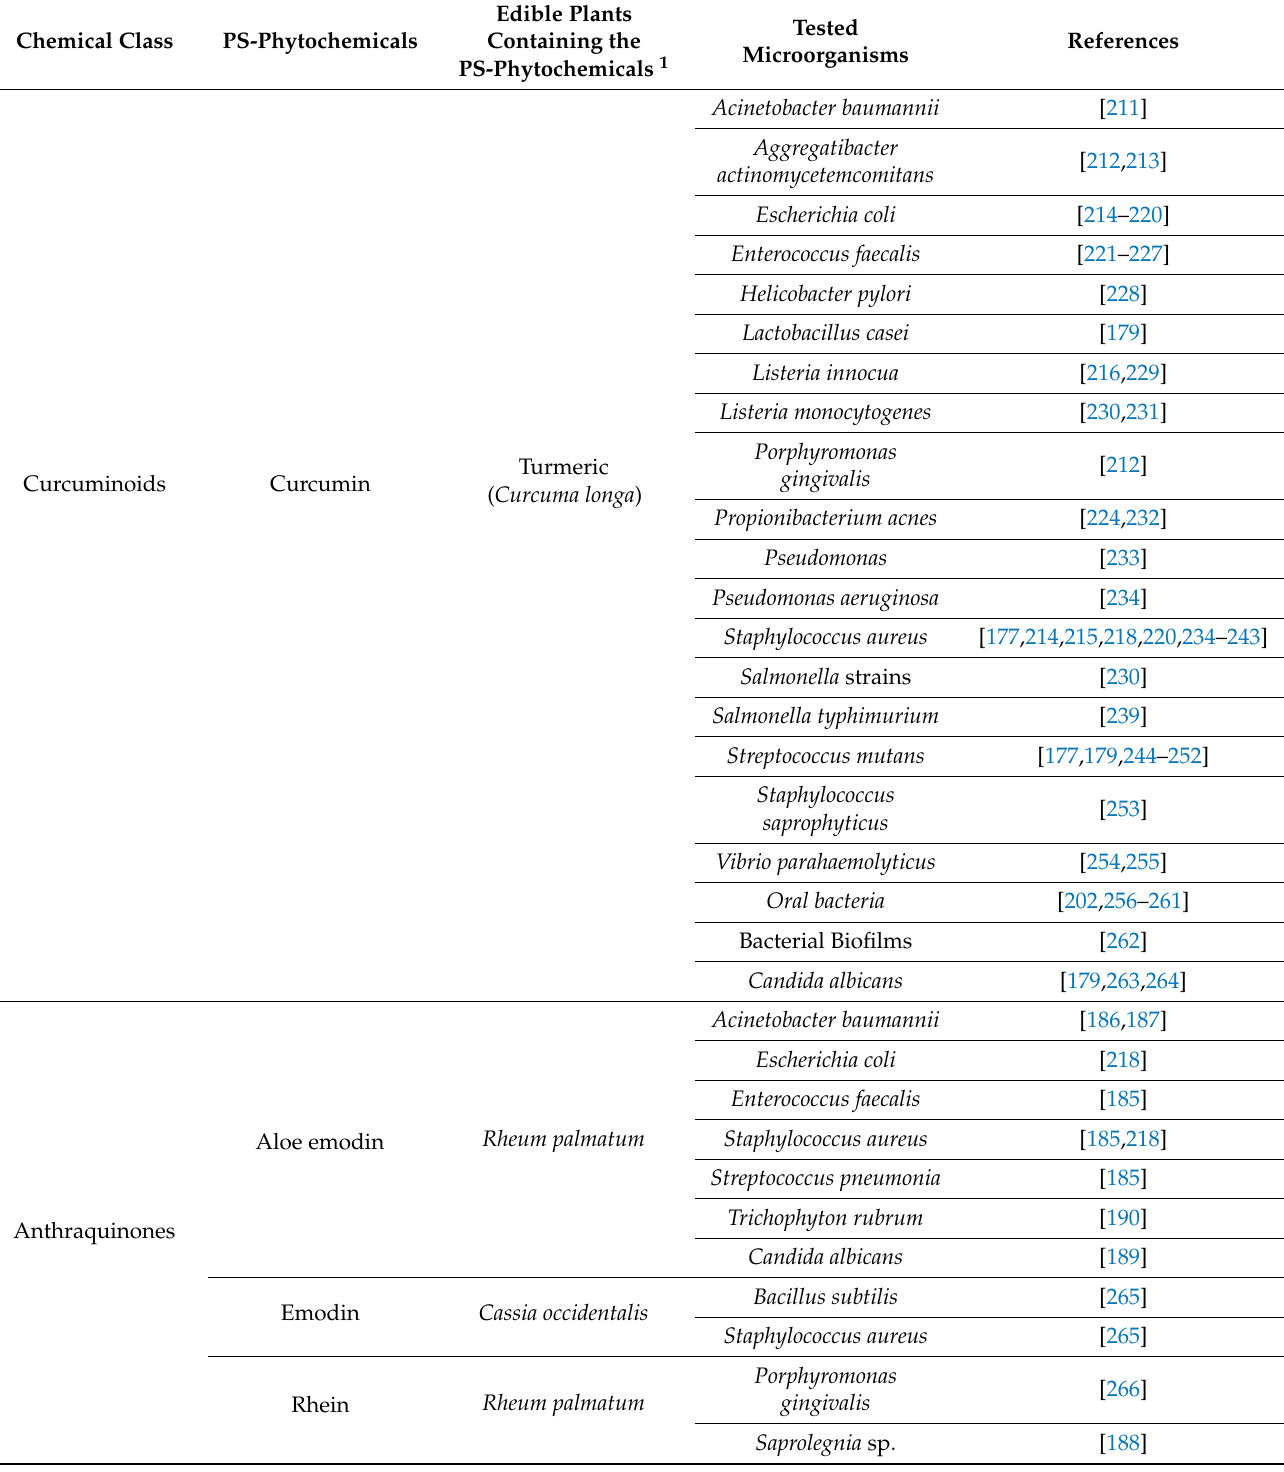
Table 3. Photodynamic antimicrobial phytochemicals from edible